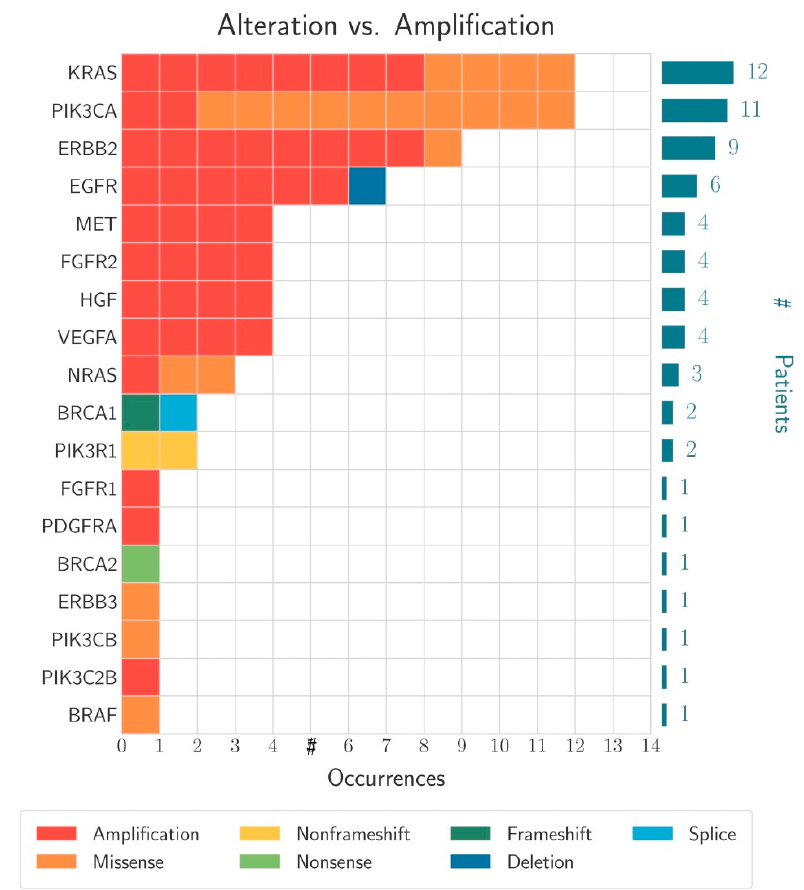
Figure 4. The different alterations in the affected genes that could be detected in the surveyed pop-